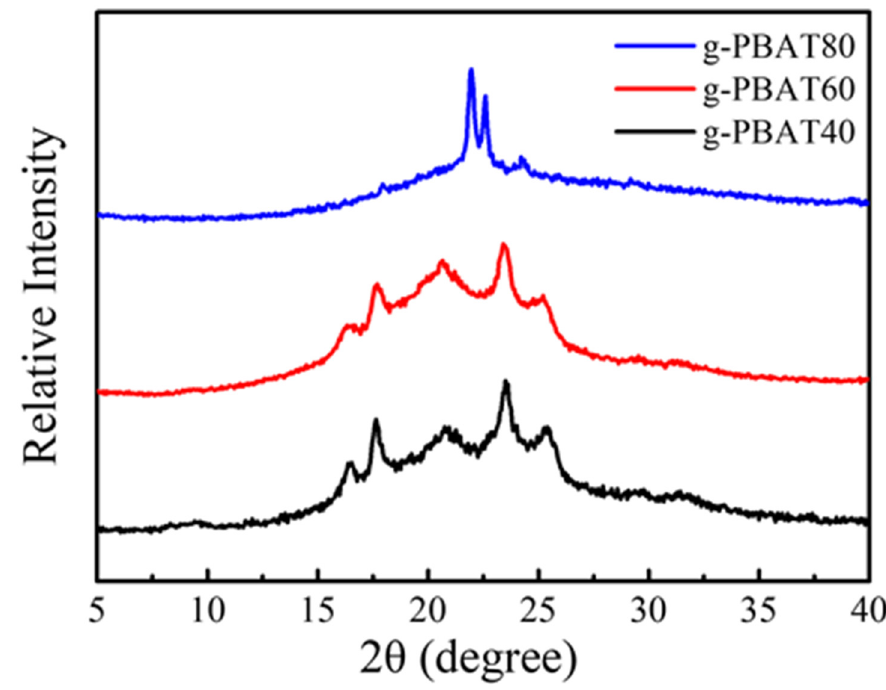
Figure 5. WAXD data for the g-PBAT-40, g-PBAT-60, and g-PBAT-80